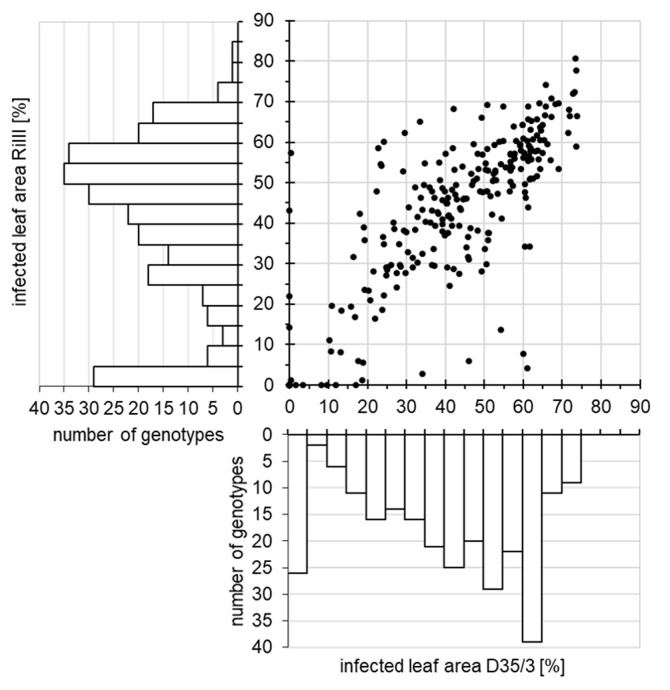
Biplot of the phenotypic distribution of the 267 Hordeum vulgare accessions included in the phenotyping-panel.Phenotypic values correspond to the arithmetic mean (n ≥3) of the normalized infected leaf area [in %] for the Blumeria graminis f. sp. hordei isolates D35/3 vs. RiIII and the corresponding absolute frequencies of genotypes per interval and isolate.